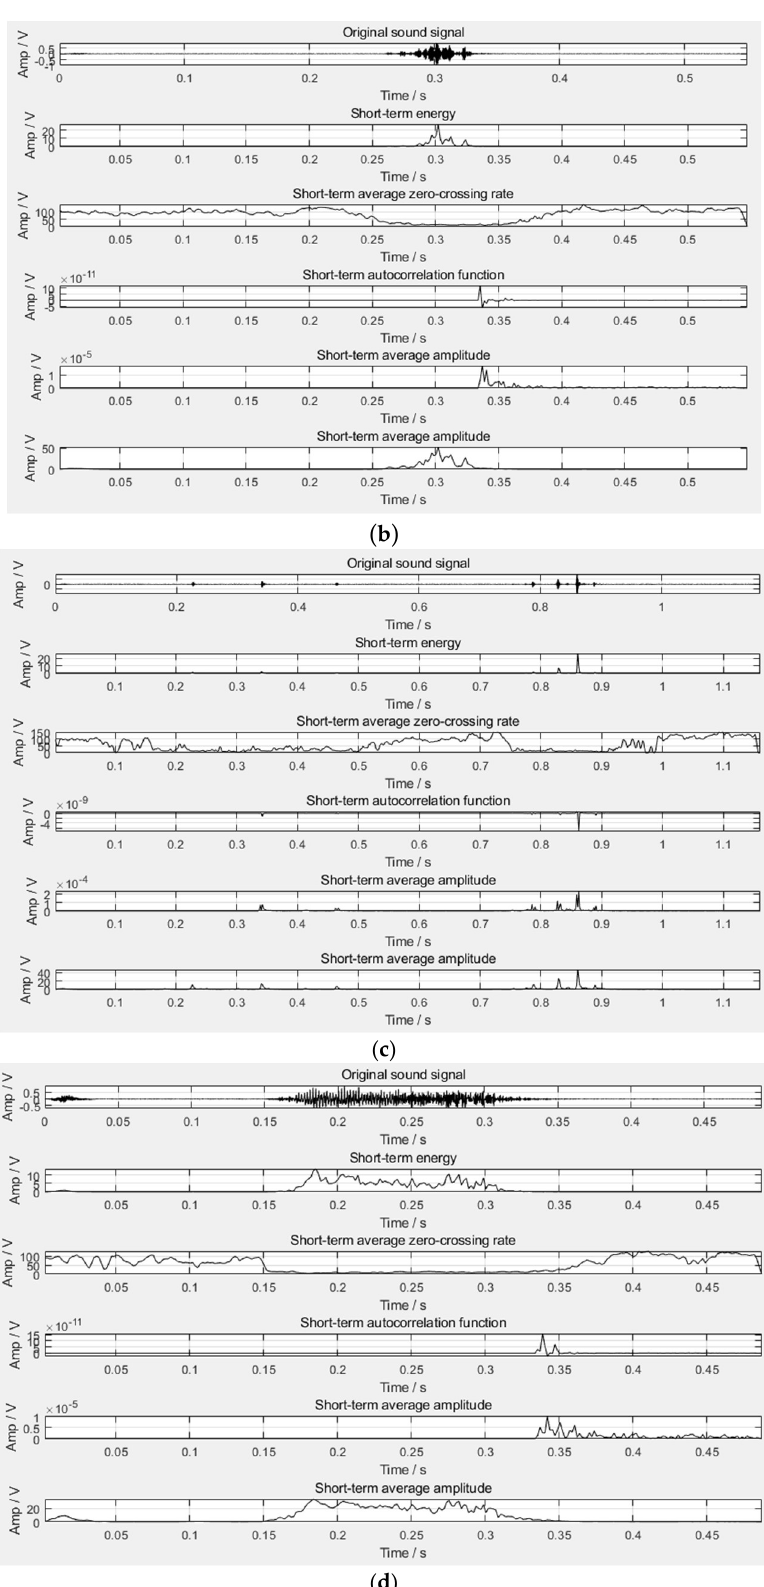
Figure 2. Time domain waveform diagram of four sound types. ( a ) Crow; ( b ) Cough; ( c ) Purr; ( d ) Flapping wings.